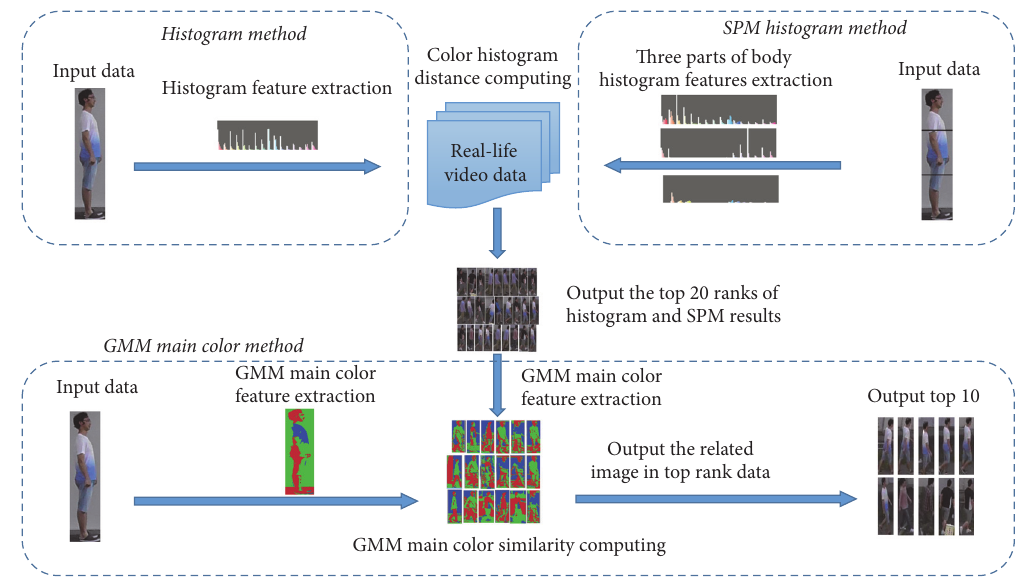
Figure 3: Overview of proposed method.